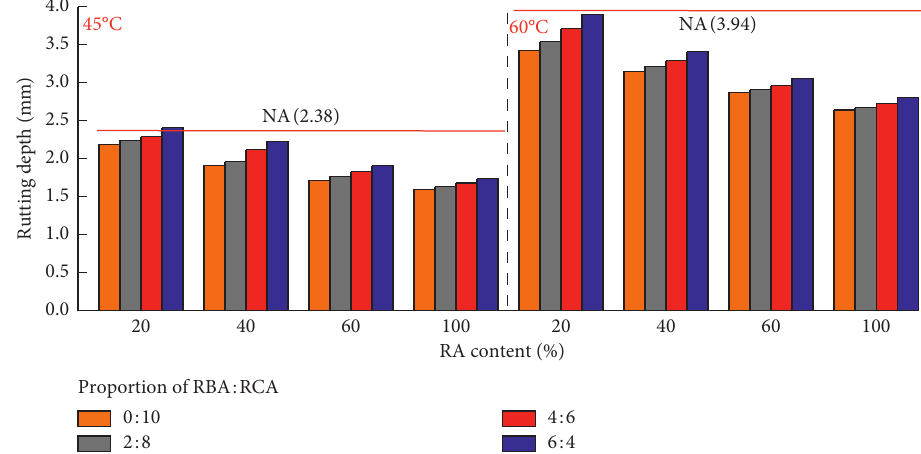
Figure 10: Rutting depth of recycled asphalt